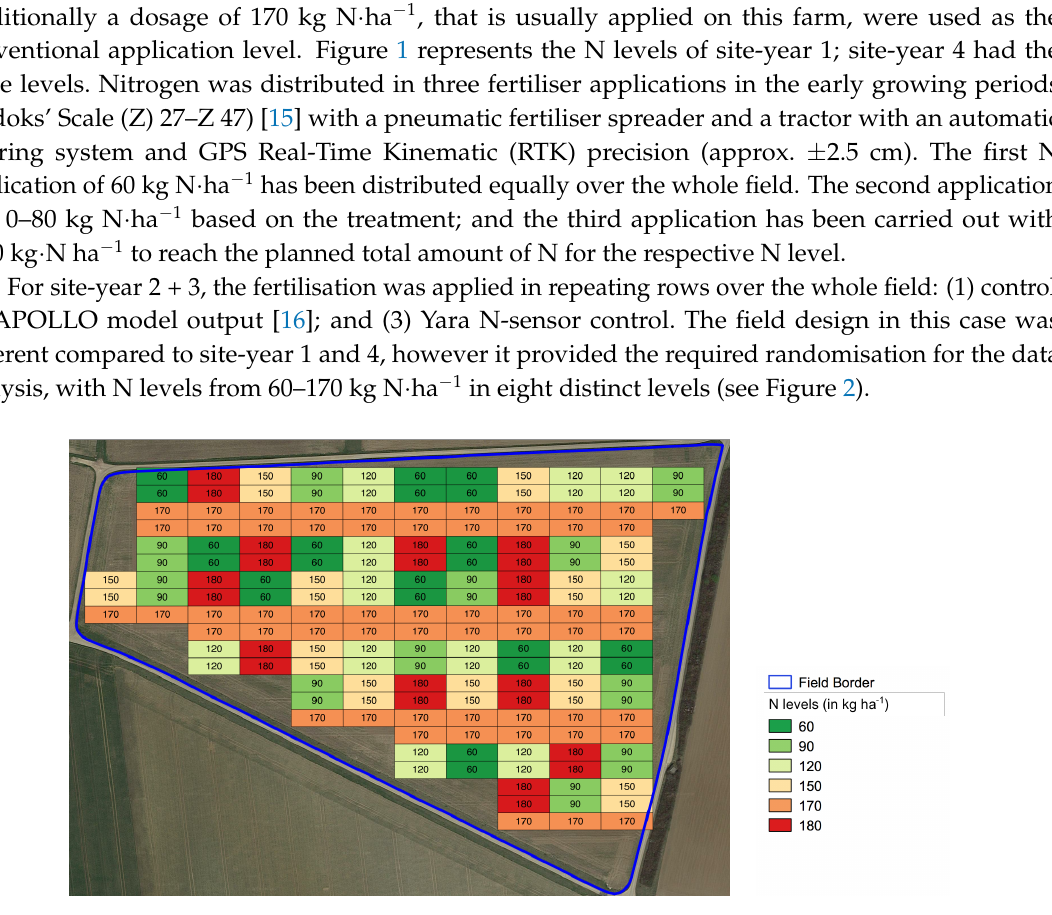
ha − 1 for site-year 1, as shown in the · 12 m (L W). × ×